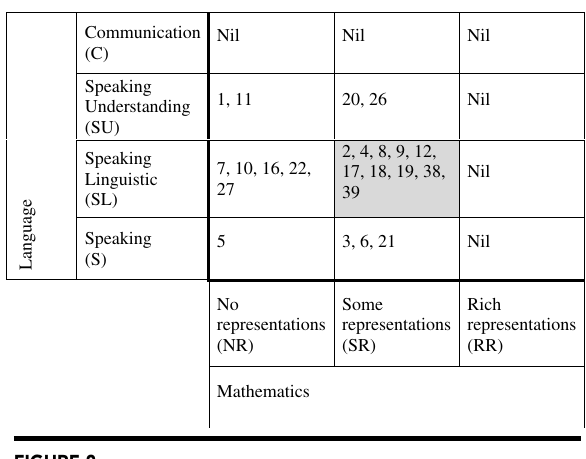
Plot mapping oral language use and degree of mathematical representation — teachers at schools with all Indigenous student population ( n =